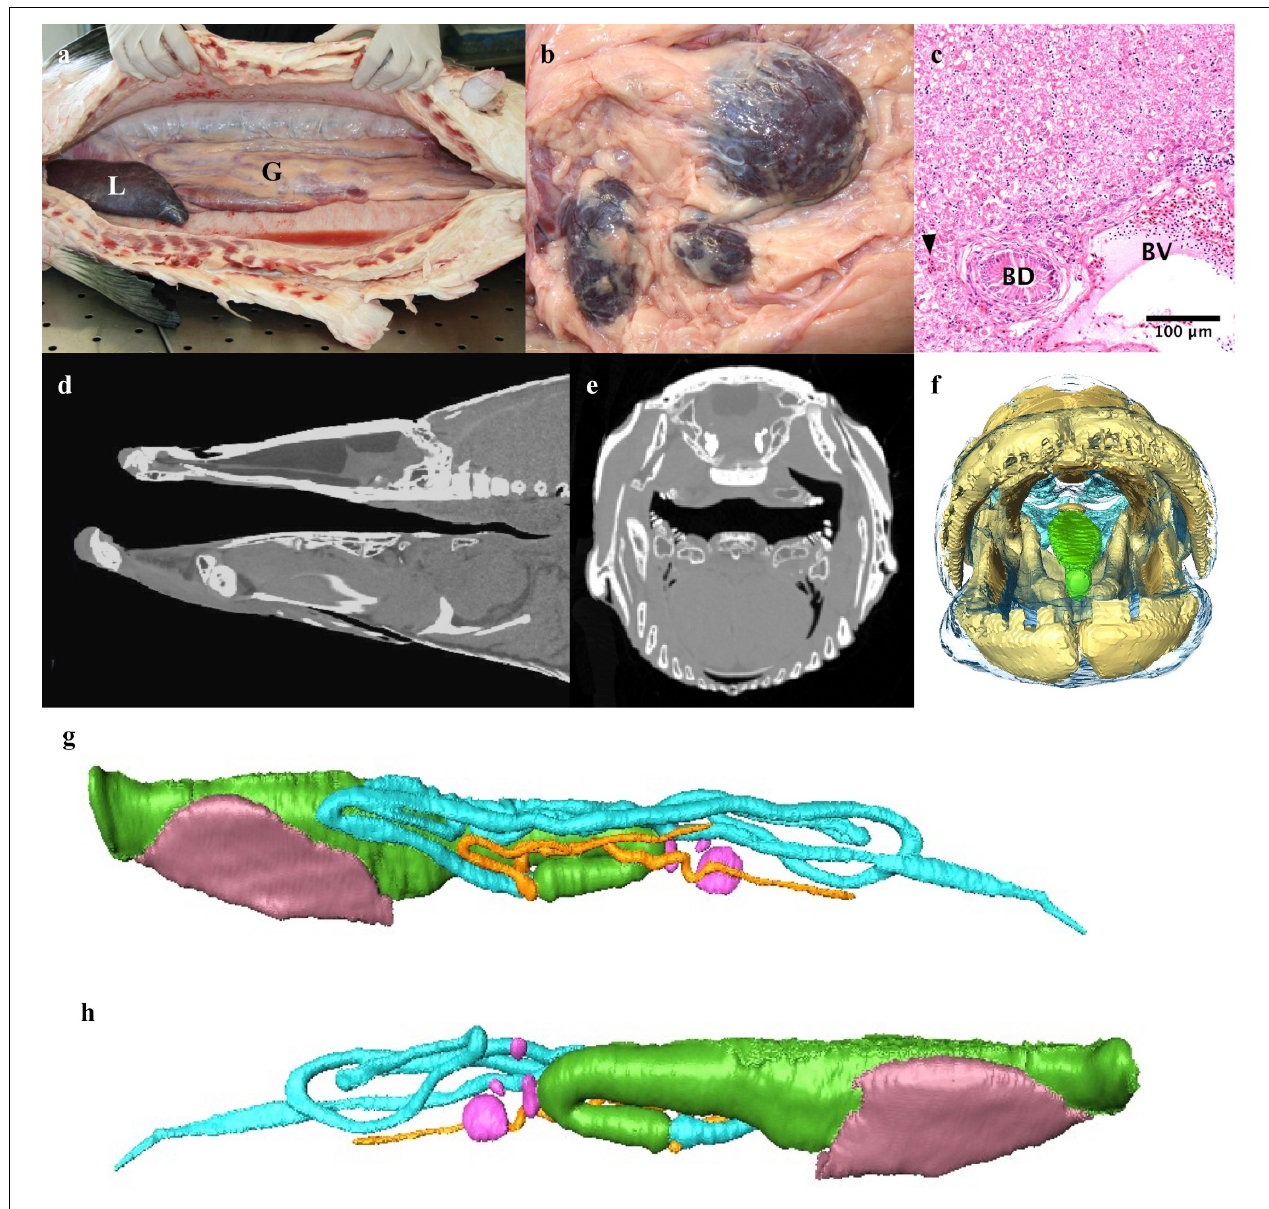
FIGURE 7 | The digestive system. (a) Abdominal cavity with liver (L) and gut (G). (b) Several spleens. (c) Light micrograph of liver showing a bile duct (BD), blood vessel (BV), sinusoids (arrowhead) and hepatocytes (top half of image). (d,e) Sagittal midline and axial CT slice through head demonstrating how effective crushing of prey occurs between boney tongue and roof of mouth. (f) 3D reconstruction of head looking into mouth highlighting boney tongue (green). (g,h) 3D model of gut and liver reconstructed from CT data. The gut of the osteoglossomorpha is distinct from that of other fishes in that the intestine passes posteriorly to the left of the esophagus and stomach (Nelson, 1972) rather than to the right. (g) left lateral, (h) Right lateral. Esophagus and stomach: green, intestinal loops: turquoise, blind ending pyloric caeca originating from proximal gut: orange, liver: brown, spleens pink.